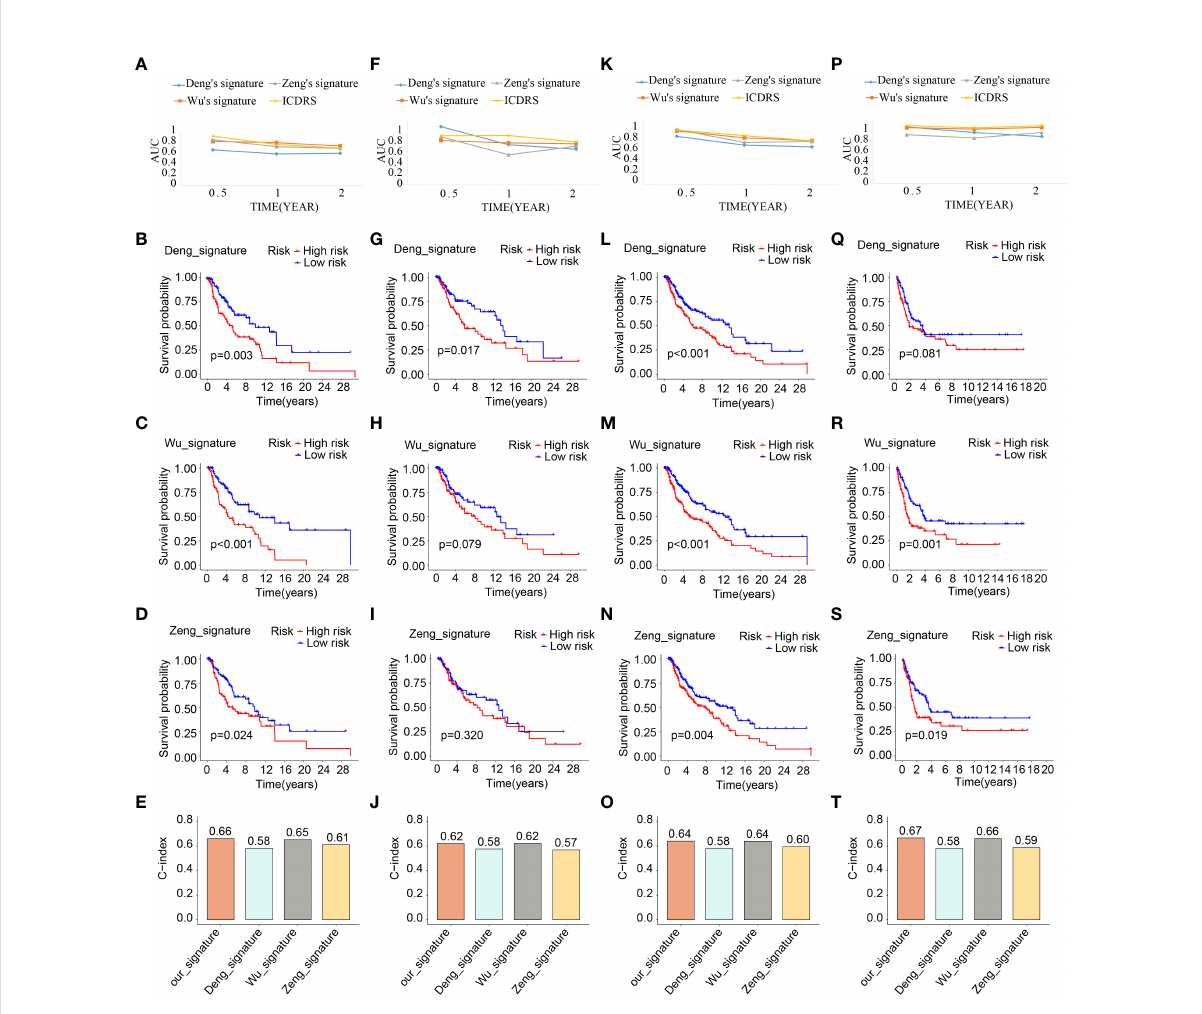
FIGURE 8 Comparative analysis of ICDRS. The comparison of AUC values, survival analysis and C-indexes between ICDRS and three additional signatures in train (A – E) , test1 (F – J) , test2 (K – O) , and test3 (P – T)